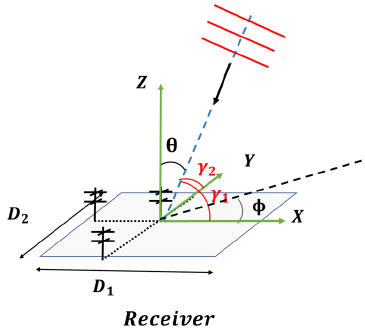
Figure A2. The receiving array geometry (only three antennas are shown for